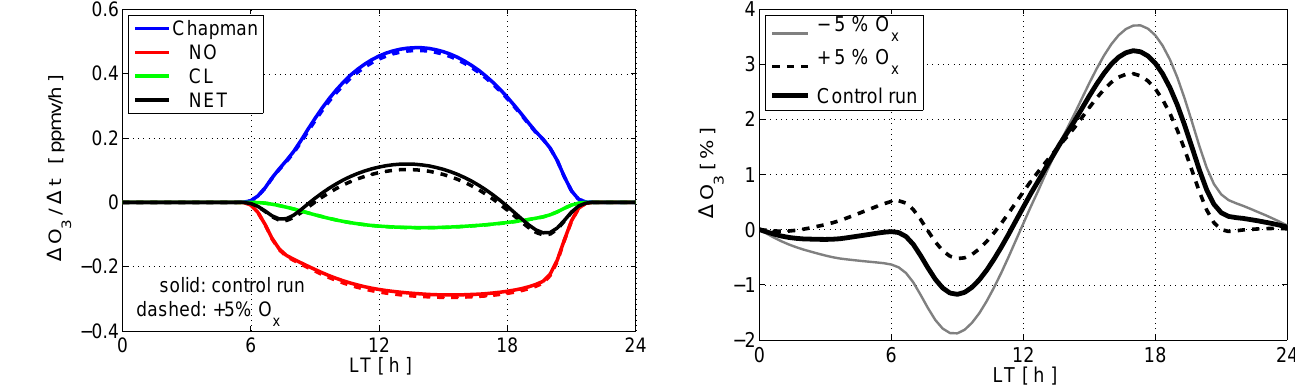
Figure 12. Daily ozone cycles derived from simulations with ± 5% initial O x concentration and a control simulation shown for 1 Jan- uary, 5hPa, 22 ◦